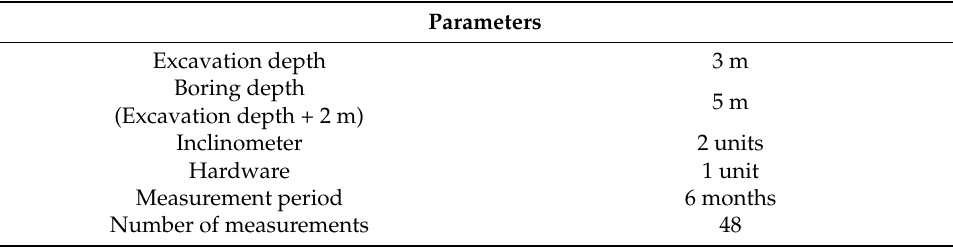
Table 4. Assumed measurement site parameters.